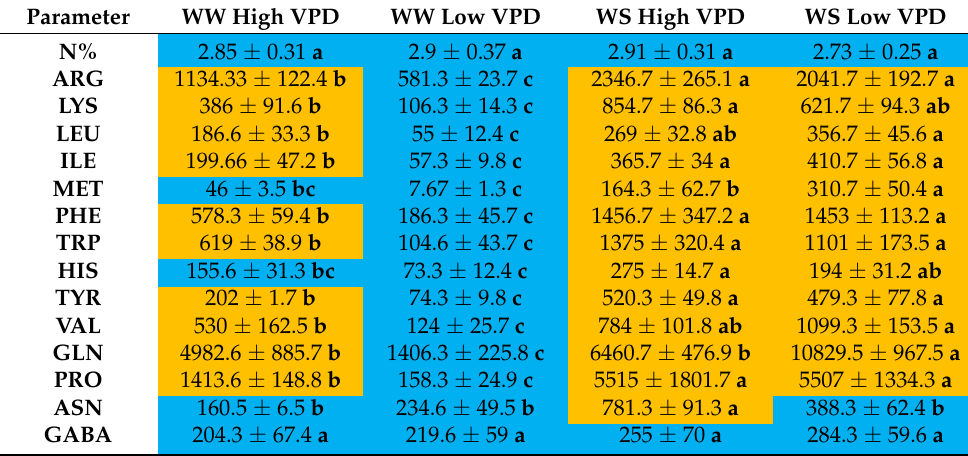
Table 1. Effect of water irrigation (pot capacity-WW- versus 50% of pot capacity-WS) and ambient vapour pressure deficit (VPD; high 40 % RH versus low 80% RH) on wheat leaf nitrogen (N, %) and amino acid ( µ g g − 1 FW) content: arginine (ARG), lysine (LYS), Leucine (LEU), isoleucine (ILE), methionine